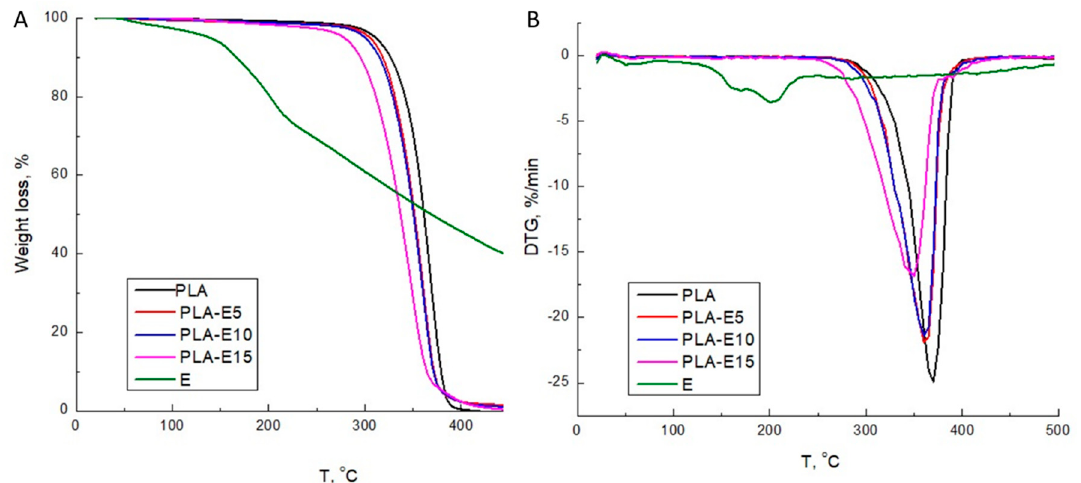
Figure 3. TG ( A ) and DGT ( B ) diagrams of stilbene-rich extract and PLA-based films.